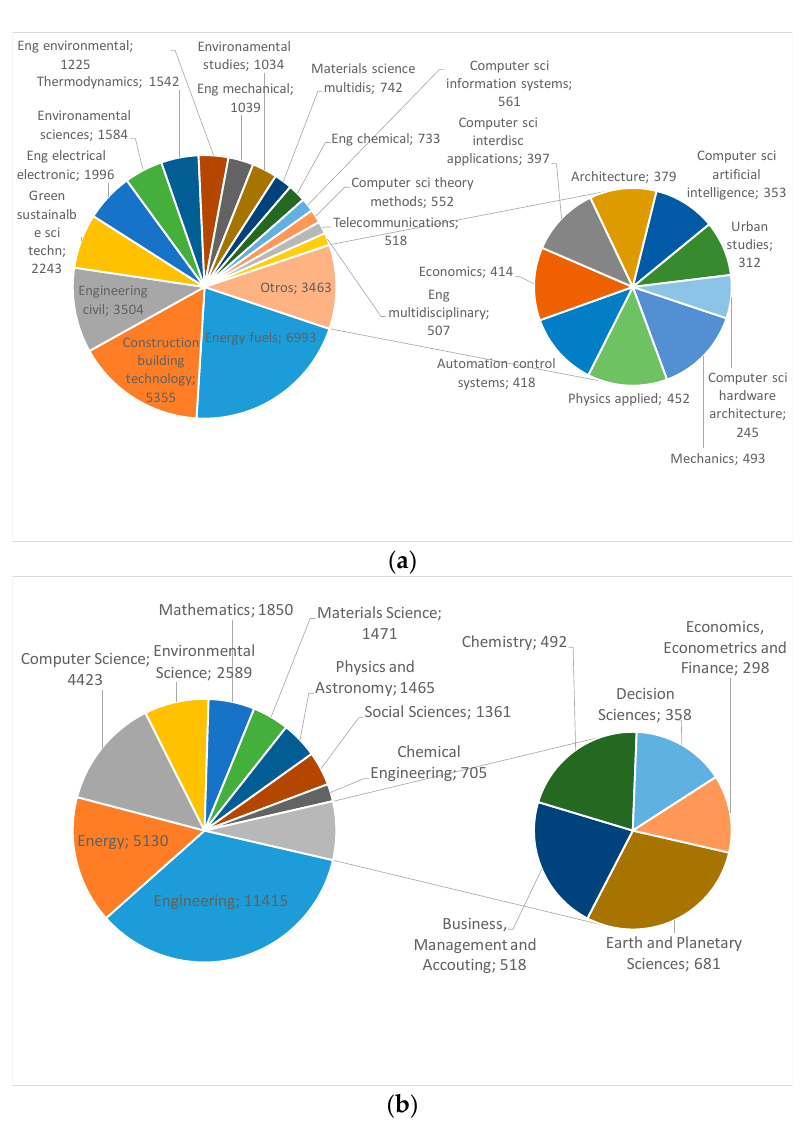
Figure 11. Distribution per subject area during the period January 2013–September 2019: ( a ) Web of Science; ( b ) Scopus.